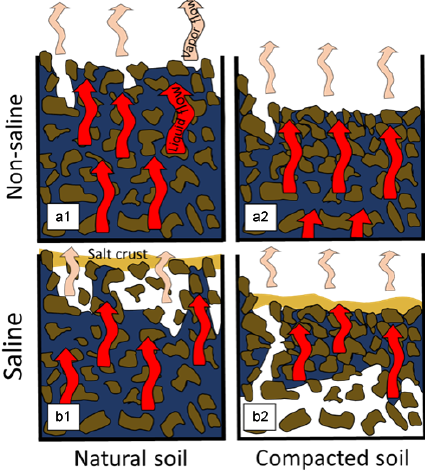
Figure 1. Conceptual model of evaporation and salt precipitation under compacted and non-compacted conditions; (a) initial stages of S1 evaporation with the first air invasion into the matrix; (b) ad- vanced stages of evaporation, where most of the soil is hydraulically disconnected from the salt crust for the non-compacted state (b1) , whereas at the compacted state most of the soil is hydraulically con- nected to the salt crust; thus, evaporation front is at the salt crust upper surface (b2) . Drying of the compacted media is from bottom to top, as liquid water is replaced by air that is flowing downward through the larger pores that act as air